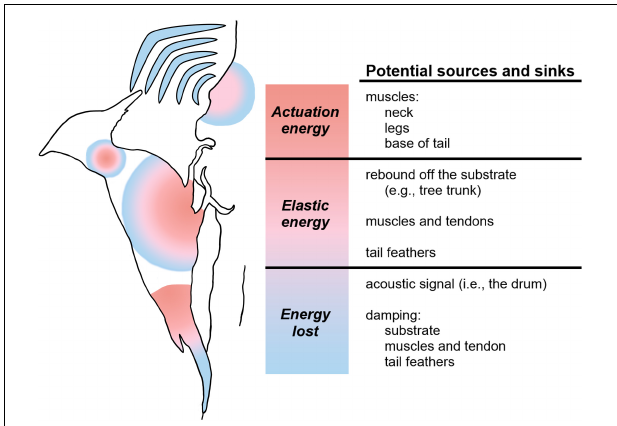
FIGURE 6 | Schematic demonstrating potential energy sources and sinks in the woodpecker drumming system. Red represents the actuation energy to begin and maintain drumming; pink, the elastic energy that aids in the continuation of the behavior after actuation; and blue, the energy lost from the